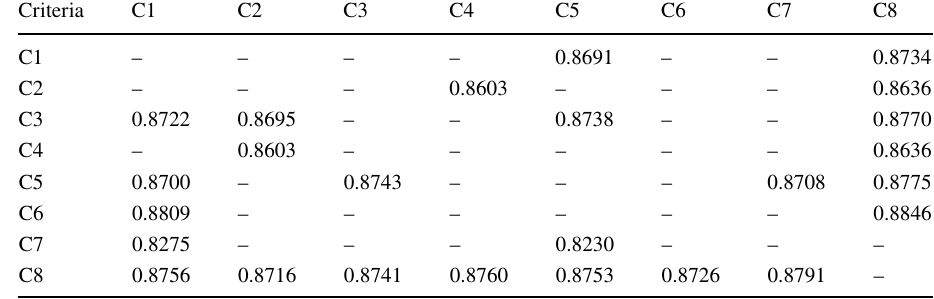
interaction matrix r _ user